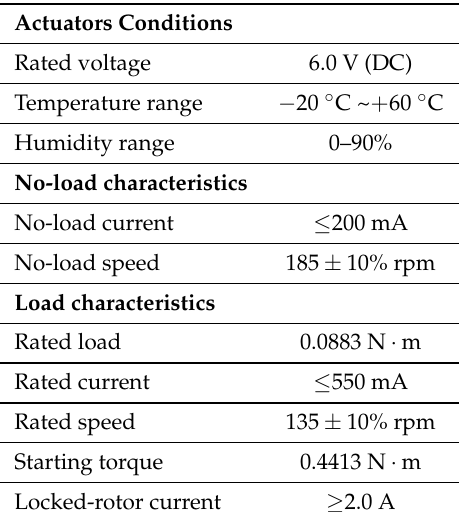
Table 2. Specification of DC motor.